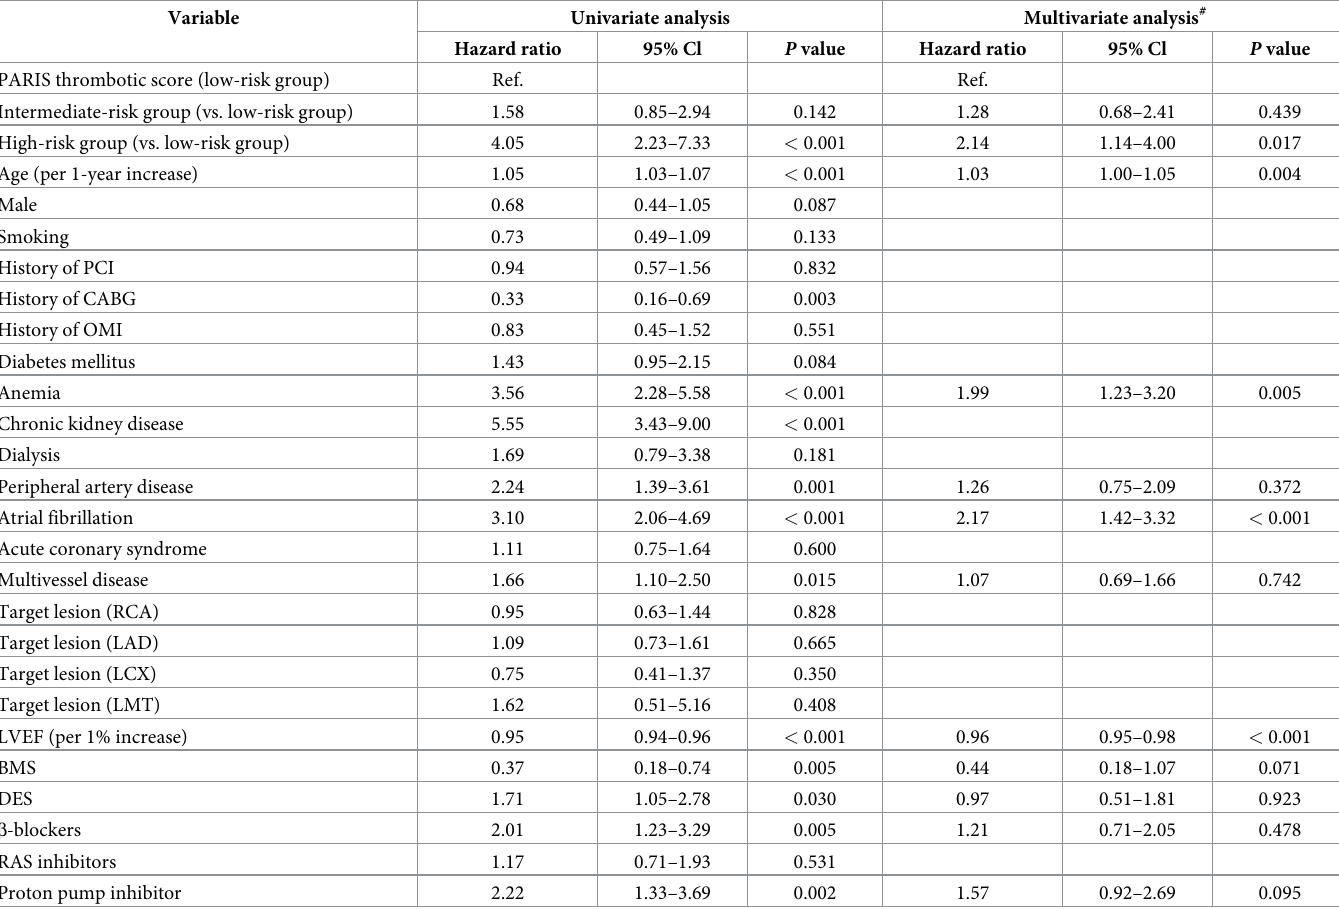
Table 4. Cox proportional hazard model of PARIS thrombotic score for hospitalization due to heart